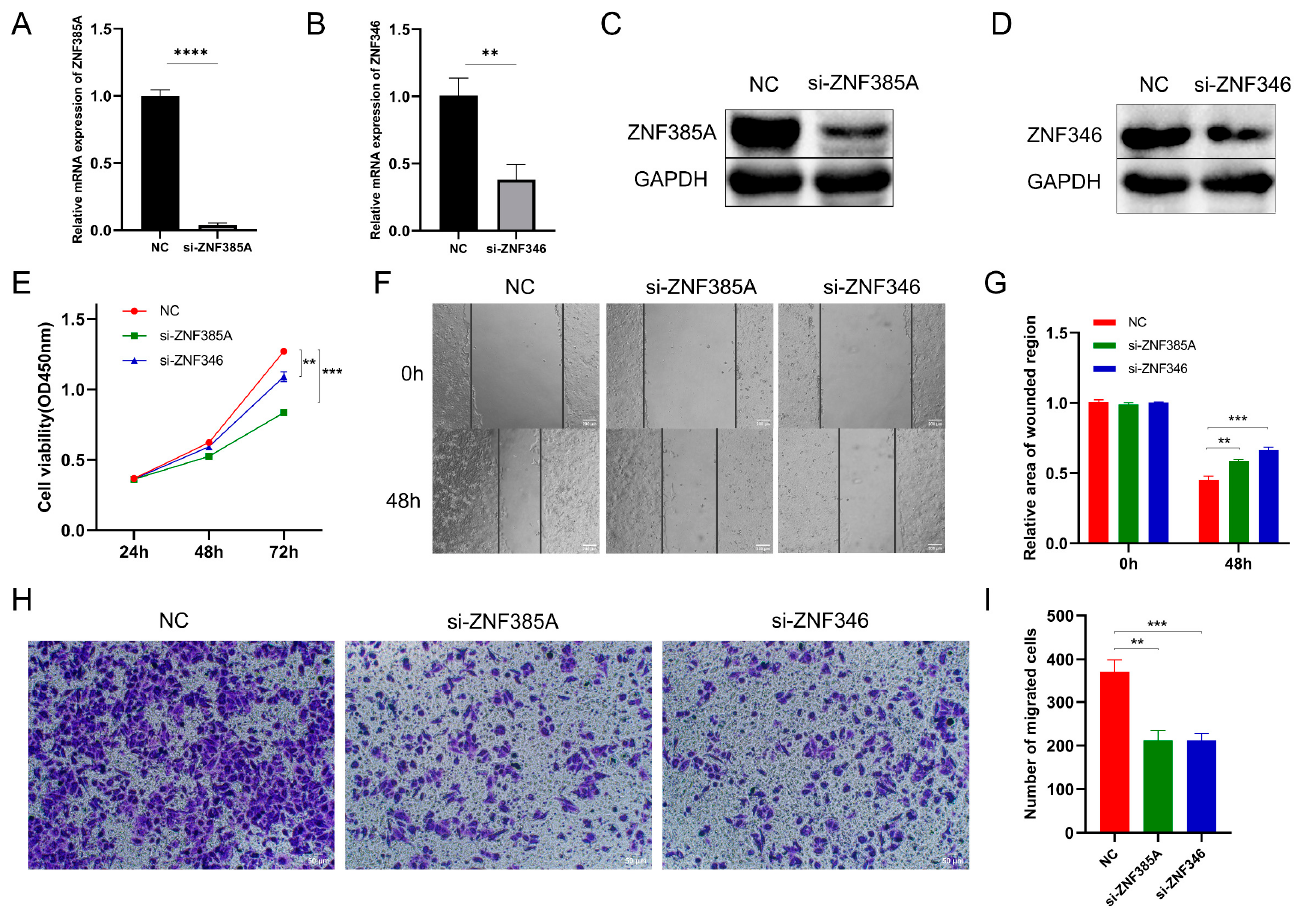
Figure 5. ZNF385A and ZNF346 promotes cell proliferation and migration in HCC. ( A , B ) The effec- tiveness of si- ZNF385A ( A ) and si-ZNF346 ( B ) in HepG2 cells via RT-qPCR. ( C , D ) The effectiveness of si- ZNF385A ( C ) and si-ZNF346 ( D ) in HepG2 cells via Western blot. ( E ) Cell viability of different groups as measured using the CCK-8 assay. ( F , G ) Cell migration capacities of different groups as measured via wound healing assay. ( H , I ) Cell migration capacities of different groups measured via transwell assay. NC: cells transfected with negative control siRNAs that did not target any genes. ** p < 0.01, *** p < 0.001, **** p <